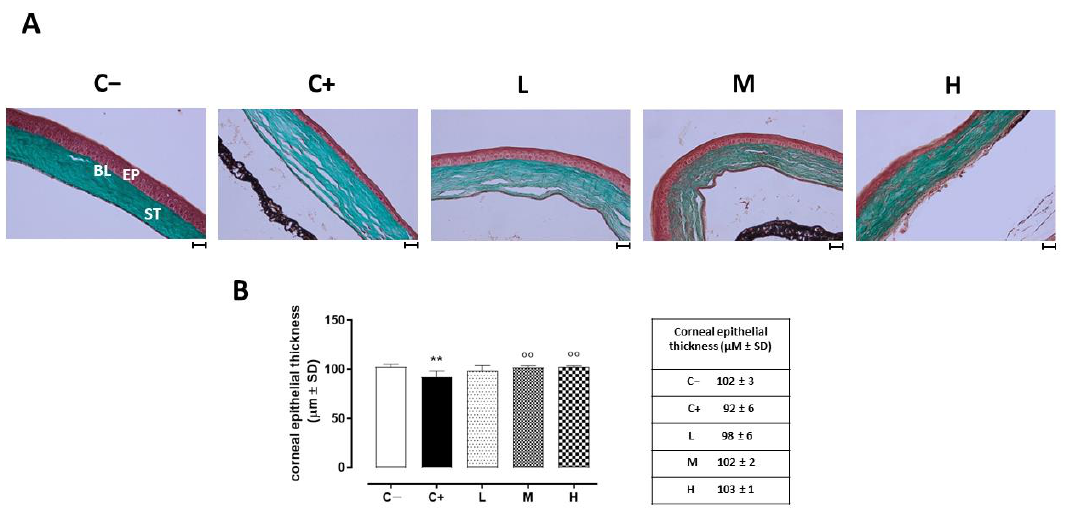
Figure 2. ( A ) Corneal GT staining in the TSP-1 KO mice euthanized at 6 weeks of age as a negative control for SS-associated dry eye (C − ); TSP-1 KO mice euthanized at 12 weeks of age as a positive control for SS-associated dry eye (C+); and TSP-1 KO mice supplied with low (L), medium (M), and high (H) doses of vitamin D3 (1000, 8000, and 20,000 IU/kg/week, respectively) from week 6 to week 12 of age. EP: corneal epithelium; BL: Bowman’s layer; ST: stroma. Scale bar: 20 µ m; magnification 40 × . ( B ) Central corneal epithelial thickness ( µ m ± SD) in the same experimental groups. N = 7 corneas per group. ** p < 0.01 vs. C − ; ◦◦ p < 0.01 vs.